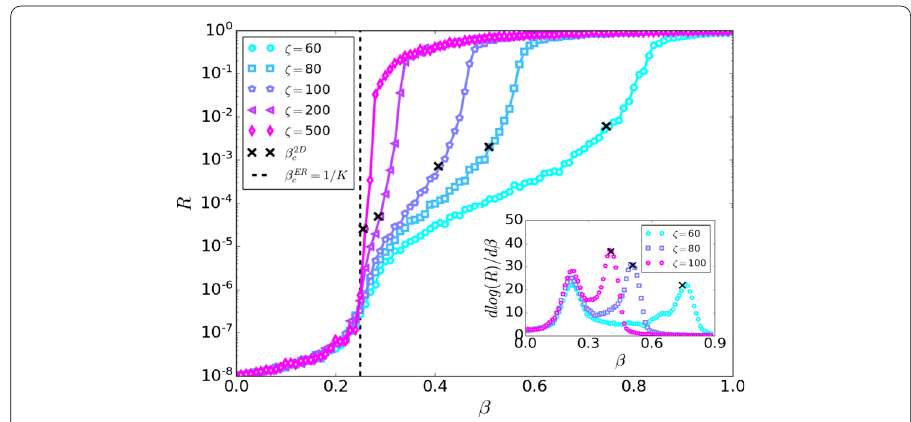
Fig. 2 Two epidemic transitions. Simulations of the epidemic recovered cluster R as a function of β for different values of ζ on a log-linear graph with K = 4 and k inter = 10 − 3 . The epidemic recovered cluster is measured once no infected nodes remain. Two distinct epidemic transitions are observed. The first (lower) transition at β ER c = 1 / K (black dashed line) occurs when a small outbreak spread in a city but not in the entire country. The second (higher) transition at β 2 D c when a global epidemic spread in the whole country is obtained from Eq. (3) and is denoted by black × . The inset shows the derivative of log ( R ) with respect to β for different values of ζ . Two maxima appear corresponding to the two epidemic thresholds for each ζ shown with × in the main figure. As ζ increase β 2 D c decreases and for ζ → L the two maximums collide. Here N = L × L ∼ 10 8 ( L = 9960 for ζ = 60 and L = 10 4 for the other ζ